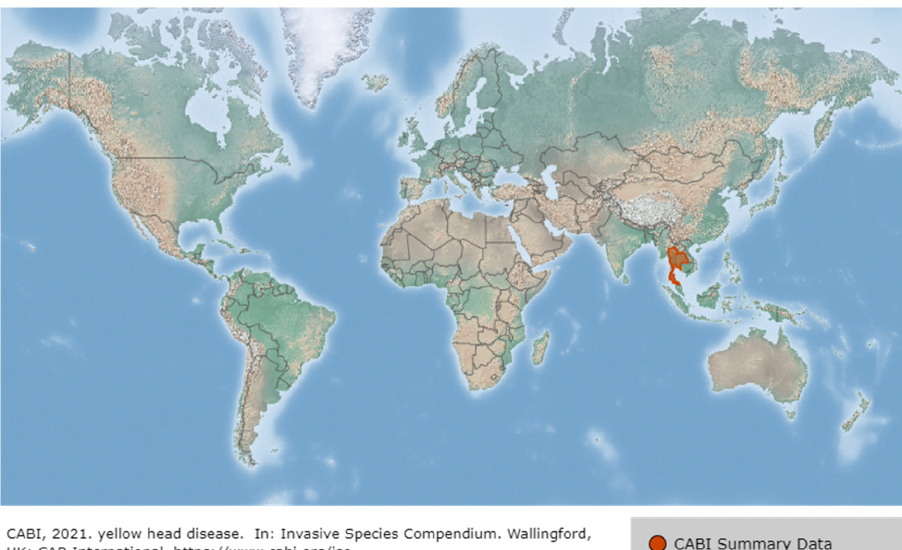
Figure 15. Distribution map showing the geographical occurrence of yellow head virus genotype 1 (YHV genotype 1) (Reprinted from CABI, 2019, Yellow head virus. In: Invasive Species Compendium. Wallingford, UK: CAB International, with permission from CABI).